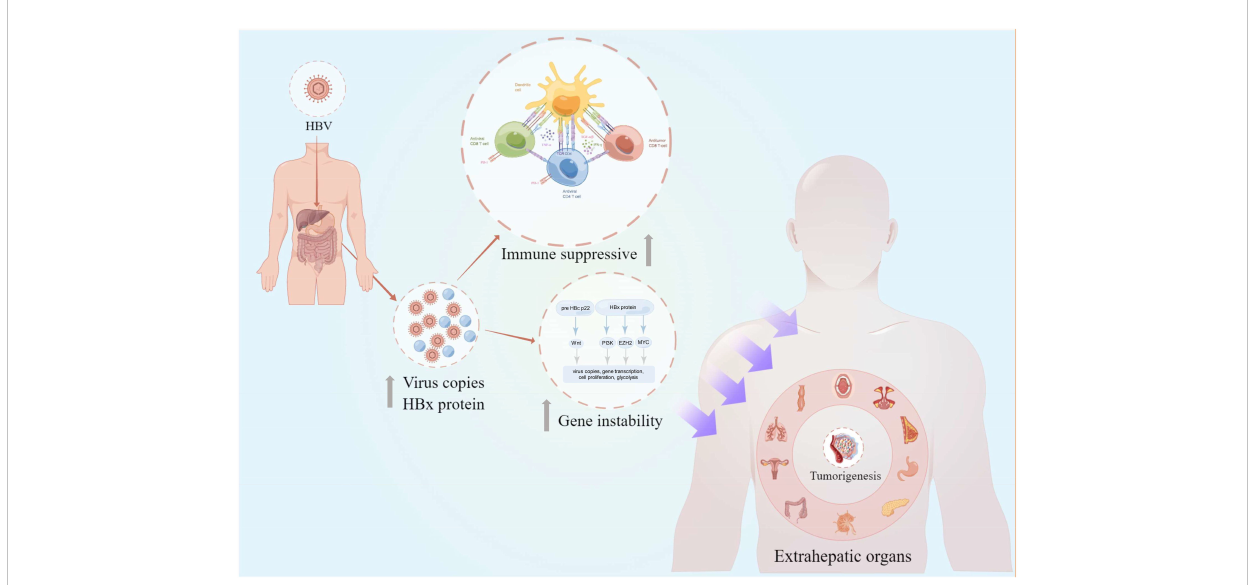
FIGURE 1 The overview of chronic HBV-mediated extrahepatic cancers in this review. The intrahepatic and extrahepatic HBV copies and HBx protein secretion could lead to the gene instability and host immunosuppressive condition. These adversely effects would further increase the risk of extrahepatic cancer risks in different organs including the oral cavity, nasopharynx, breast, stomach, pancreas, lymph, colorectum, cervix, lung, and esophagus (clockwise description). HBV, hepatitis B virus; pre HBc p22, pre-hepatitis B core protein 22; HBx, hepatitis B virus X; TGF- b , transforming growth factor- b ; TNF- a , tumor necrosis factor- a ; IFN- g , interferon g ; PD-1, programmed cell death protein 1; This fi gure was drawn with the tool “ Figdraw ” by Dr. Yu Min and Xiaoyuan Wei. HBV, hepatitis B